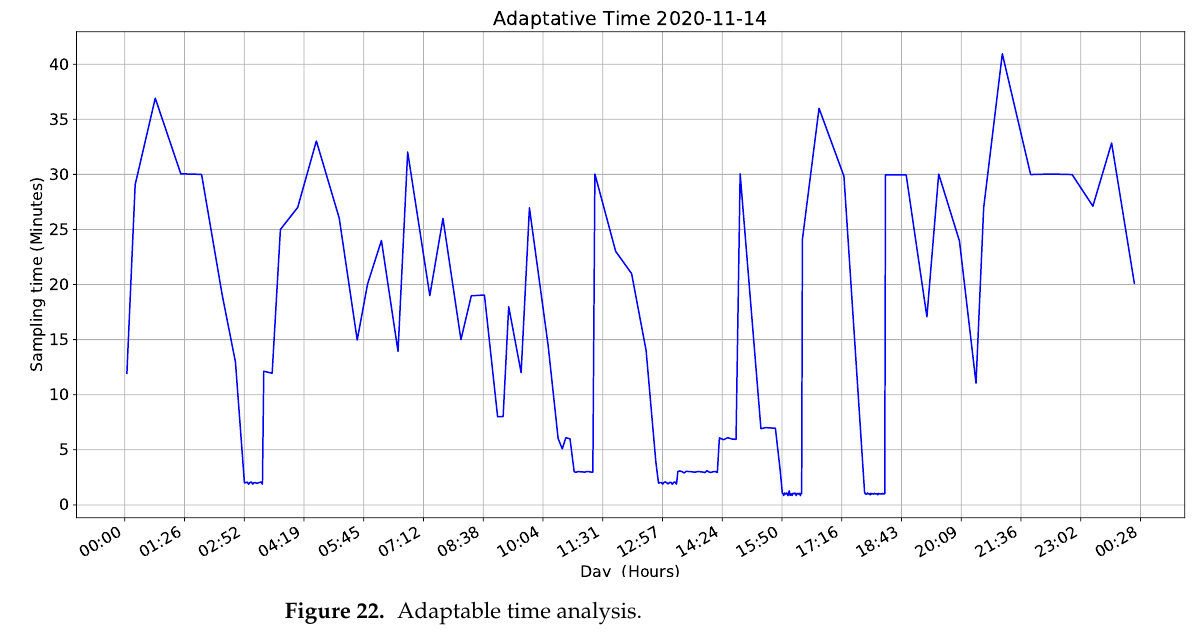
Figure 22. Adaptable time